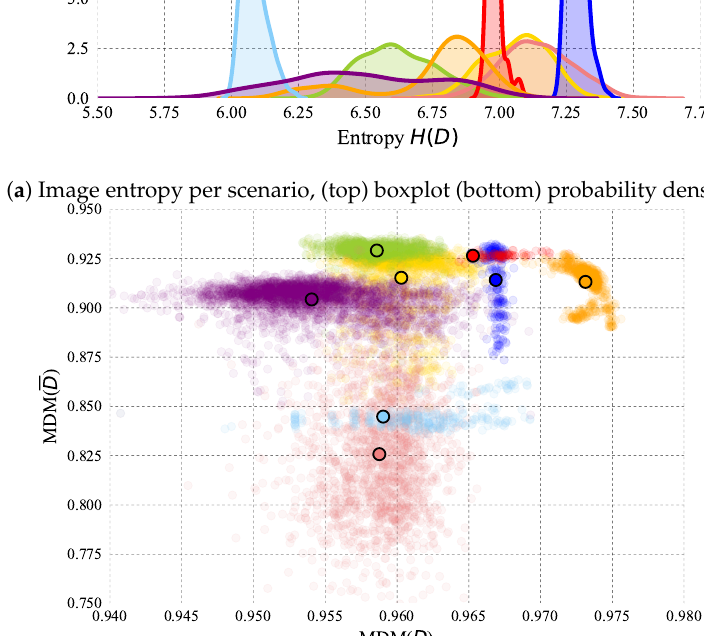
Figure 5. Dataset image quality assessment using MDM metric [22] based on Minkowski